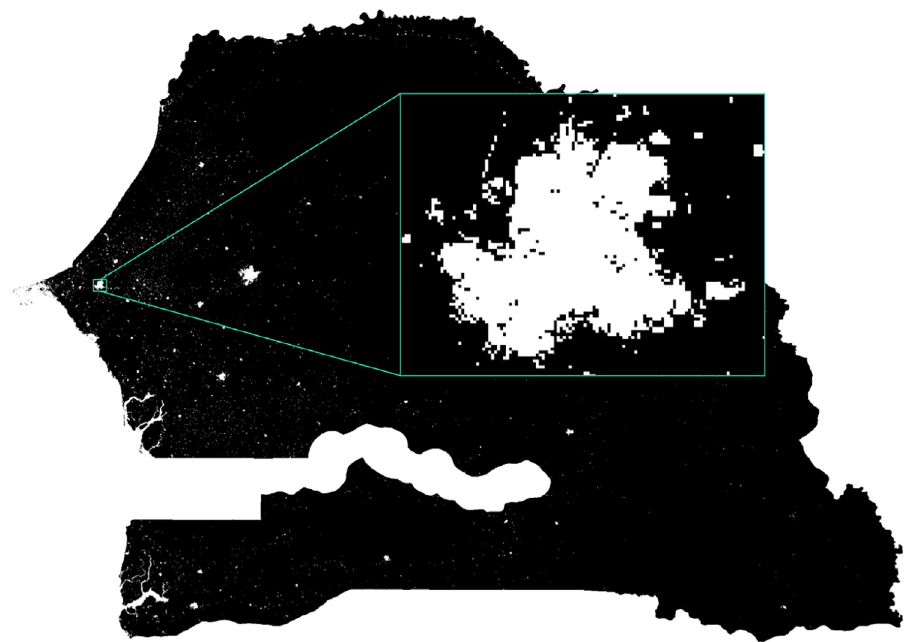
this figure for illustrative